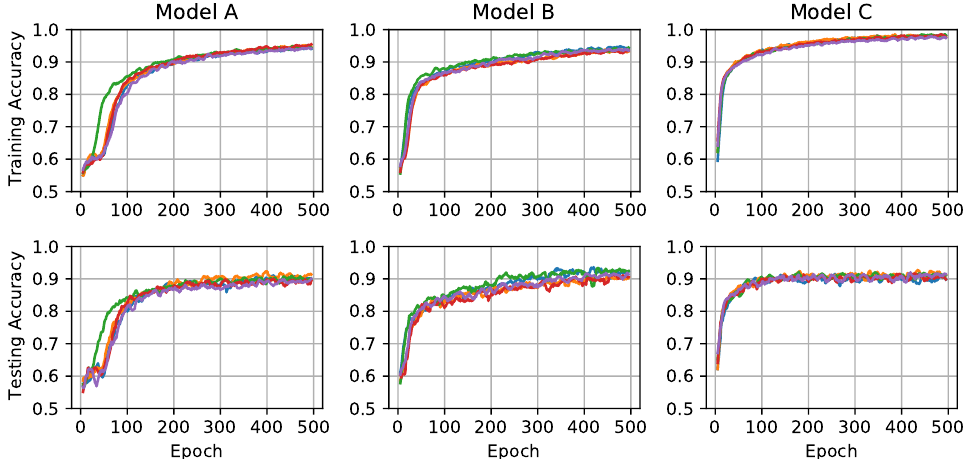
Figure 5. The accuracy of each architecture on training data ( top ) and testing data ( bottom ) during model training. Each line represents a different fold of the k-fold cross validation ( k = 5) and are running averages over 10 epochs for clarity. Architectures correspond to those described in Tables